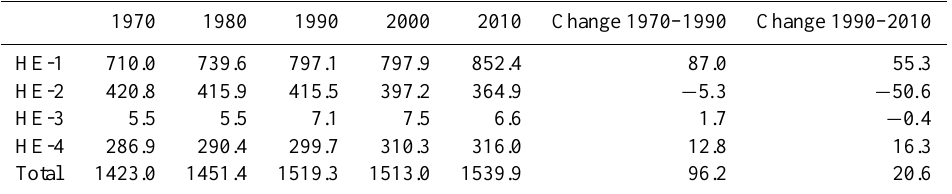
rized in Table A15, showing by hydro-economic class the areas equipped for irrigation, and in Table A16,